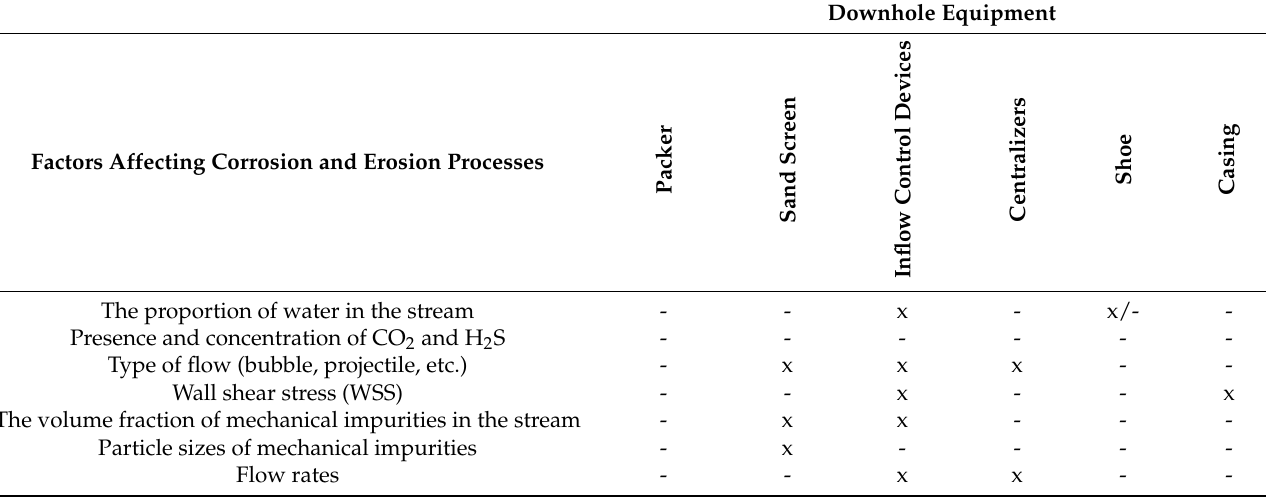
Table 1. Effect of operation of downhole equipment on the parameters of corrosion and erosion processes. Downhole